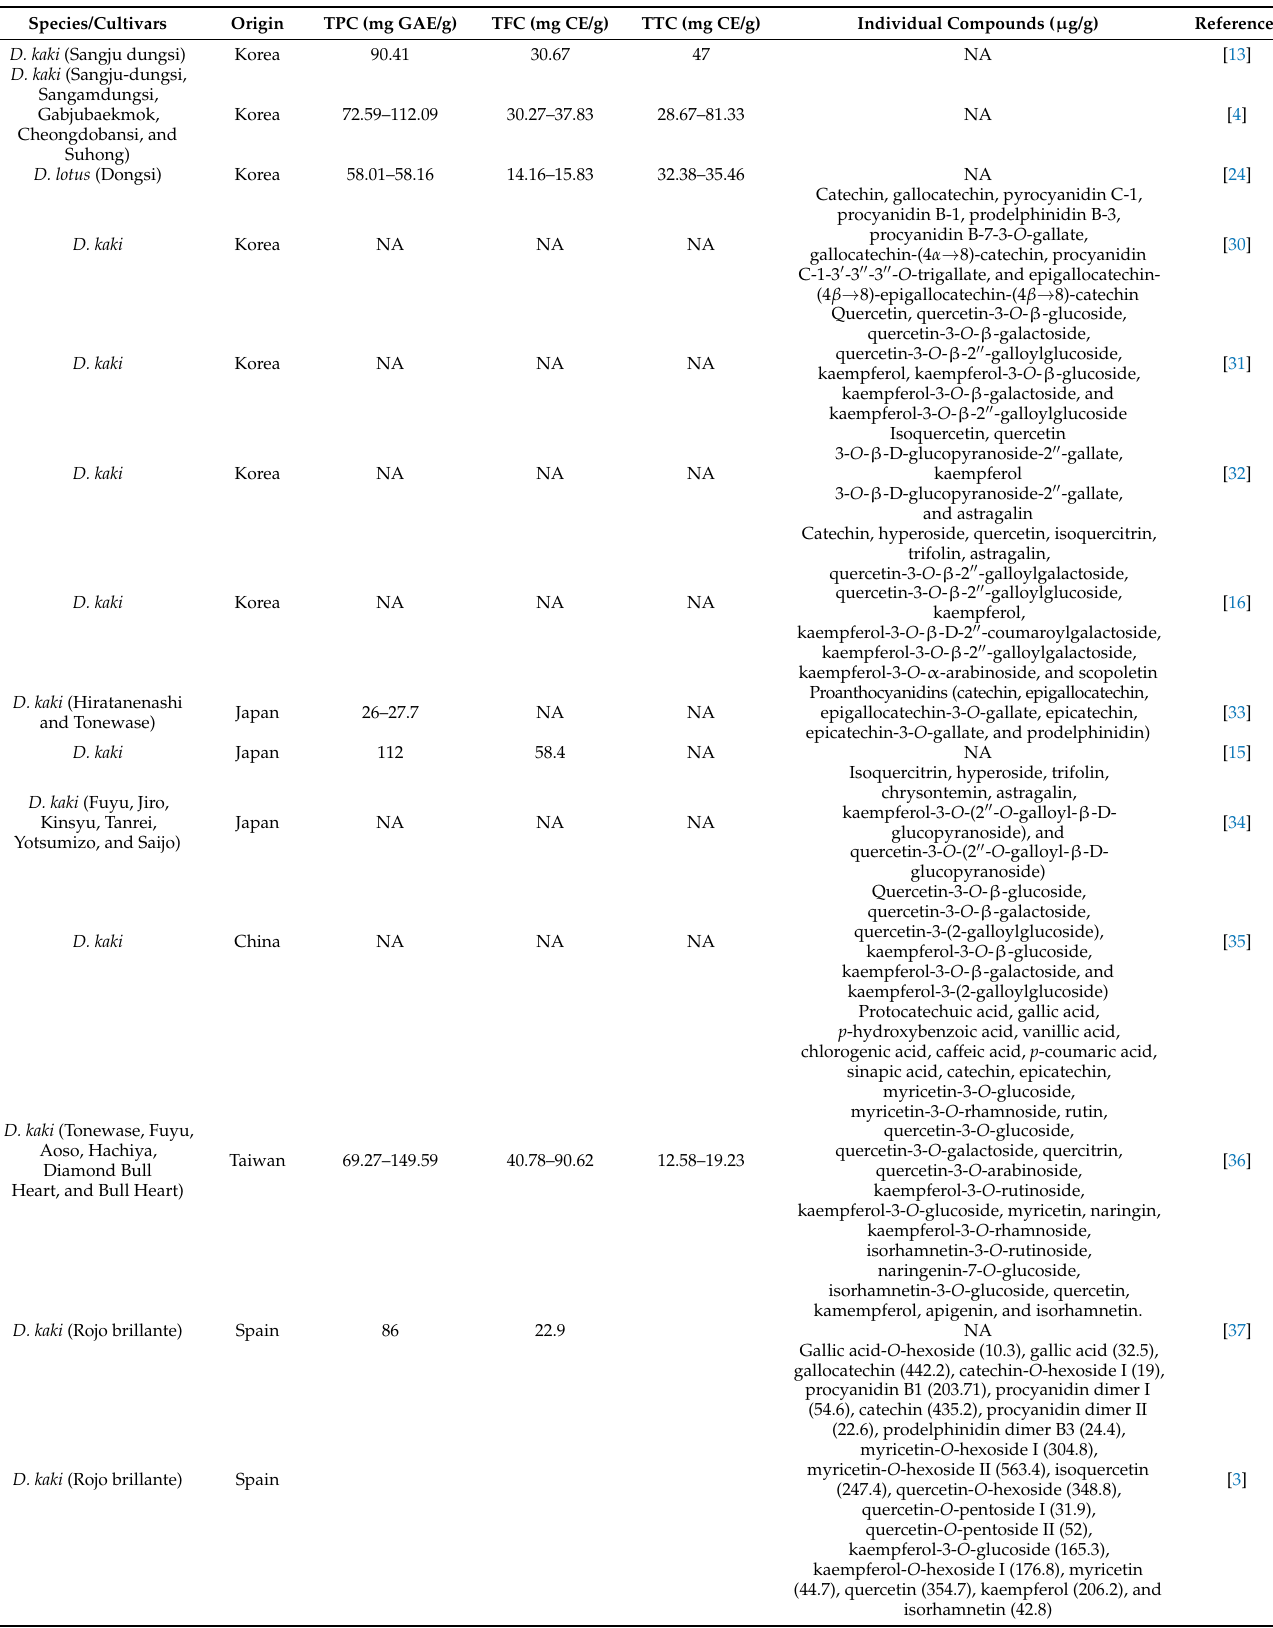
Table 1. Major phenolic compounds in persimmon